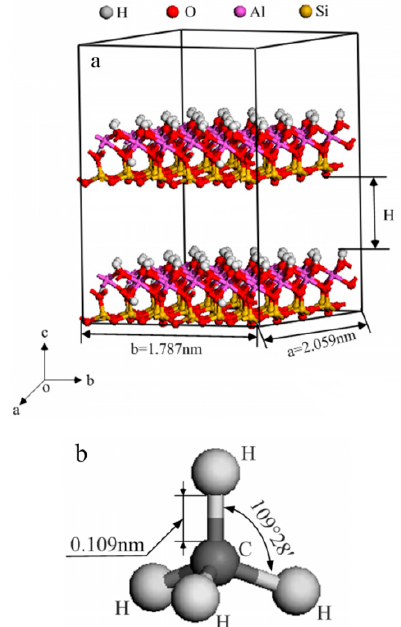
Figure 1. The 4 × 2 × 2 kaolinite (001) surface super model ( a ) and CH 4 molecular model ( b ) [17].